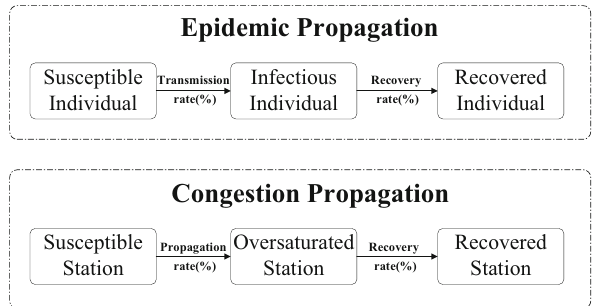
Fig. 1 Comparison between epidemic propagation and congestion